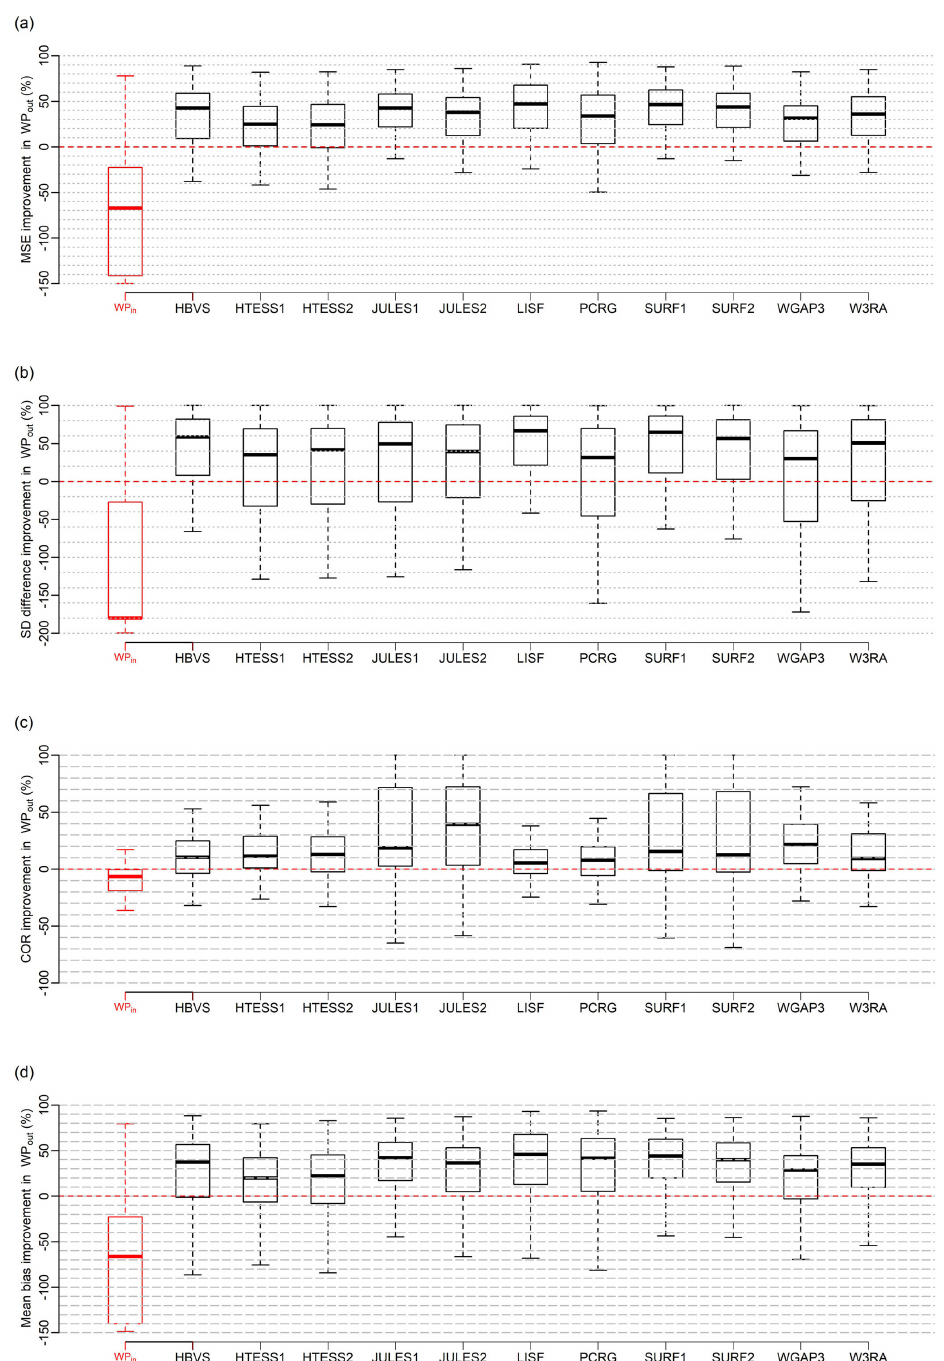
Figure 4. Box-and-whisker plots displaying the percentage improvement that the weighted product (WP out ) offers when tested out of sample, using four metrics: MSE (a) , SD difference (b) , COR (c) and mean bias (d) , when compared to the weighted product derived from in-sample data (WP in ) and each runoff product involved in this study. Box-and-whisker plots represent values calculated at 482 gauged basins. See Table 1 for dataset abbreviations. The lower and upper hinges of a box plot represent the first ( Q 1 ) and third ( Q 3 ) quartiles respectively of the performance improvement results, and the line inside the box plot shows the median value. The extreme of the lower whisker represents the maximum of (1) min(dataset) and (2) ( Q 1 − IQR), while the extreme of the upper whisker is the minimum of (1) max(dataset) and (2) ( Q 3 + IQR), where IQR represents the interquartile range (i.e. Q 3 − Q 1 ) of the performance improvement results. A median line located above the 0 axis is an indication that the out-of-sample weighting offers an improvement in more than half of the